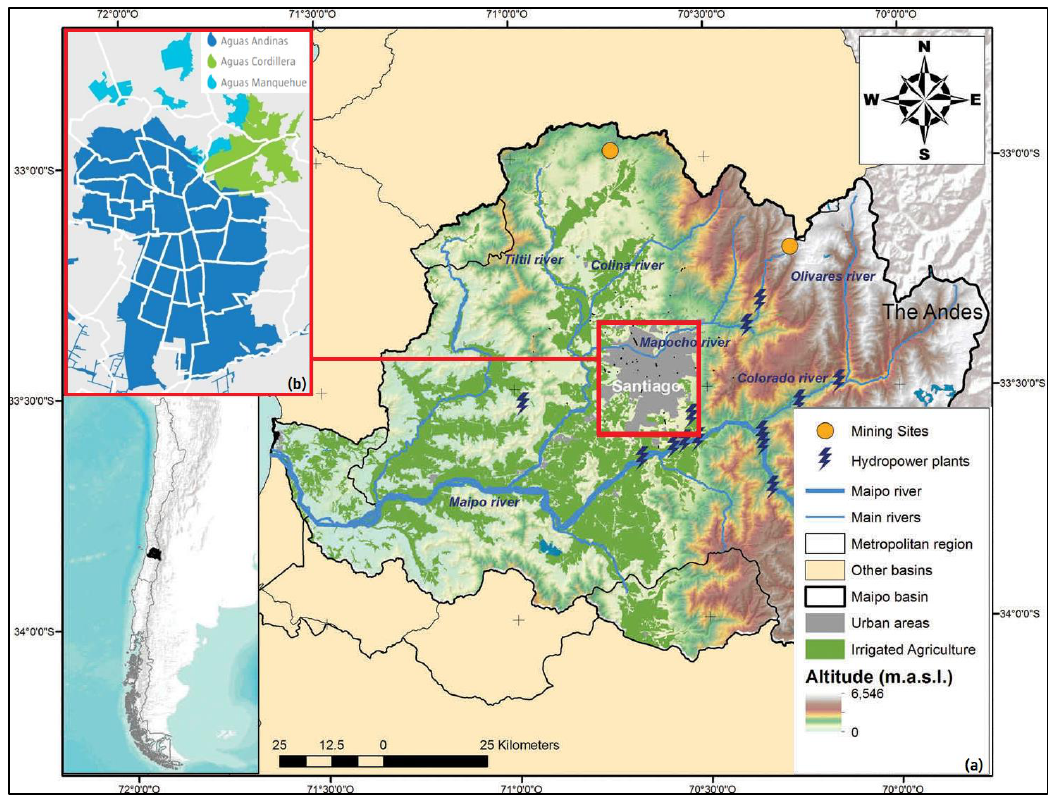
Figure 1. Study Area: ( a ) City of Santiago and the Maipo basin; ( b ) Grupo Aguas’ areas of operation in Santiago. Modified from Aguas Andinas [22] and Vicuña et al. [16].